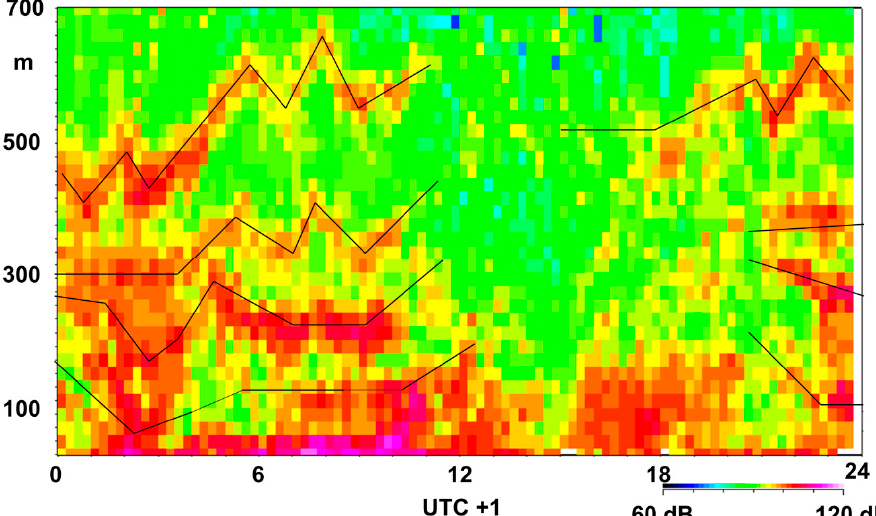
Figure 1. Multi-level layering in a calm wintry Alpine valley. Time-height cross-section of acoustic reflectivity (in dB) from a surface-based sodar in the Inn Valley east of Innsbruck on 29 January 2006. The image covers 24 h (UTC+1, from left to right) and a 660 m height interval from 40 m to 700 m above ground (from below to top). Green colors indicate lower reflectivity and red colors higher reflectivity. The thin black lines indicate borders between air layers within increasing potential temperature from lower to higher layers (adapted from [47]).